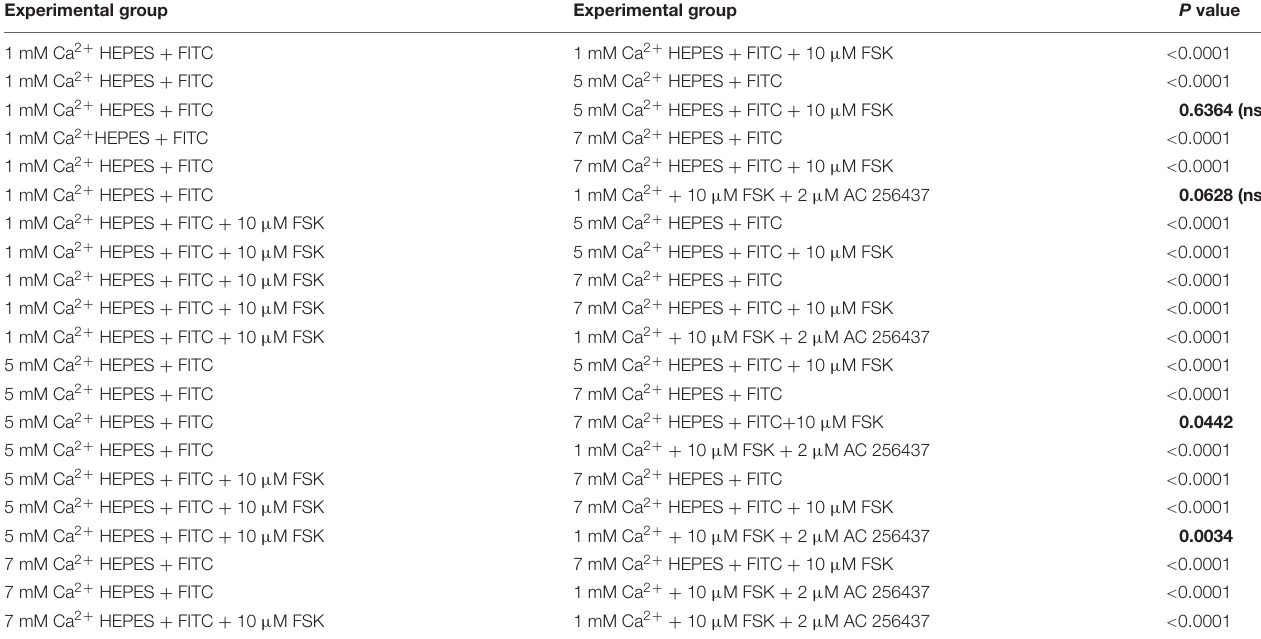
TABLE 6 | Distal region of small intestine. P values of (cid:49) Fluorescence/Minute with the different [Ca 2 + ] and FSK in comparison to AC-265347 with FSK. Experimental group Experimental